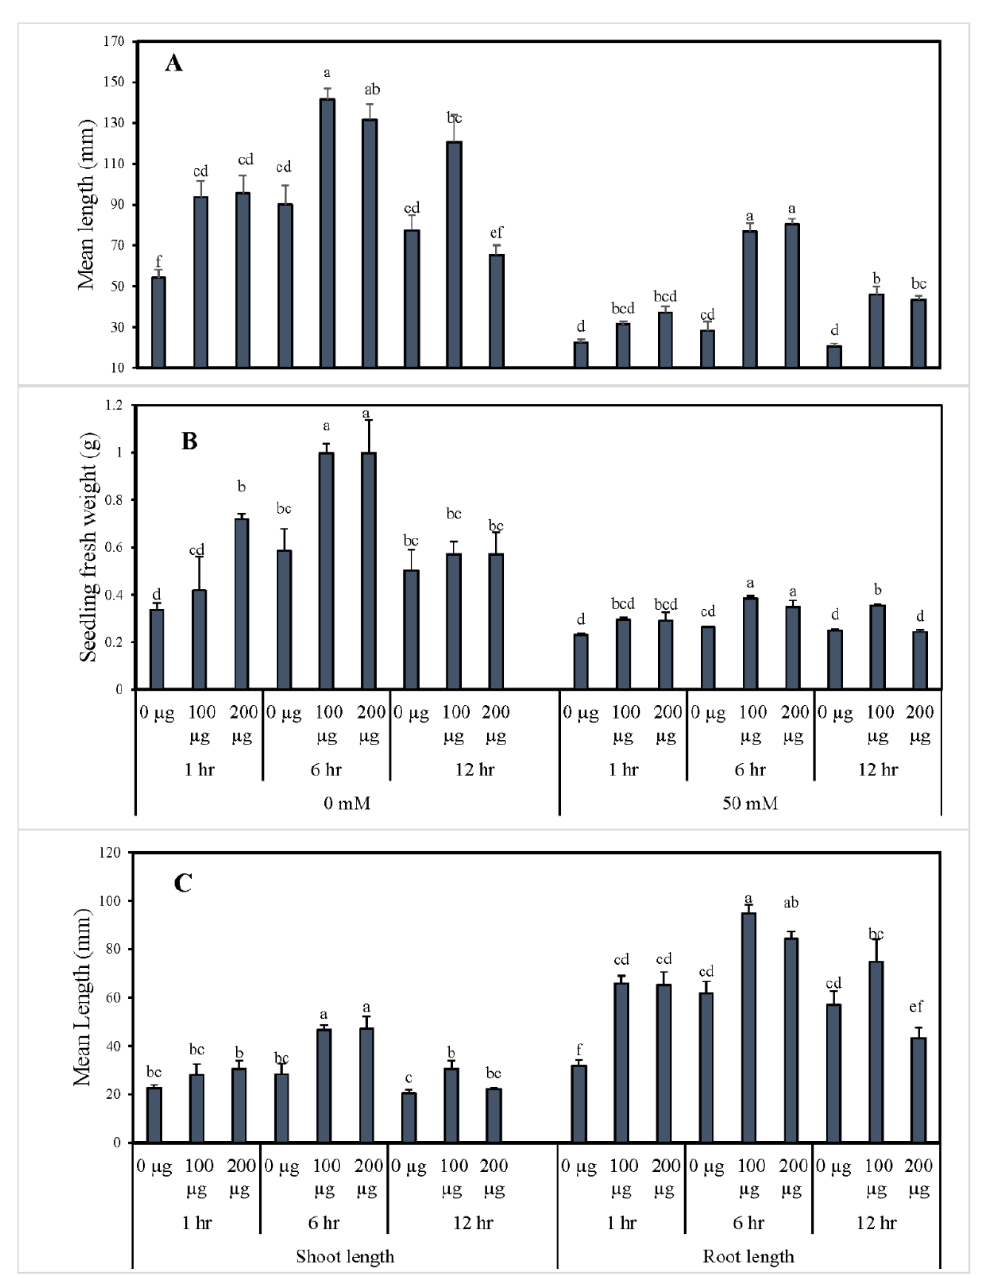
Figure 2. Morphological indices of tomato seedlings obtained from seed priming with AGE. Tomato seeds were primed with 0, 100, and 200 µg ∙ mL − 1 AGE for 1, 6, and 12 h and germinated in 0 and 50 mM NaCl stress conditions. Obtained data were subjected to analysis of variance (ANOVA) using factorial design. Differences among the means were calculated with Tukey’s HSD ( p = 0.05). Bars represent mean values and standard errors for four replicates (10 seedlings per replicate). Means followed by the same letters bear no significant difference.